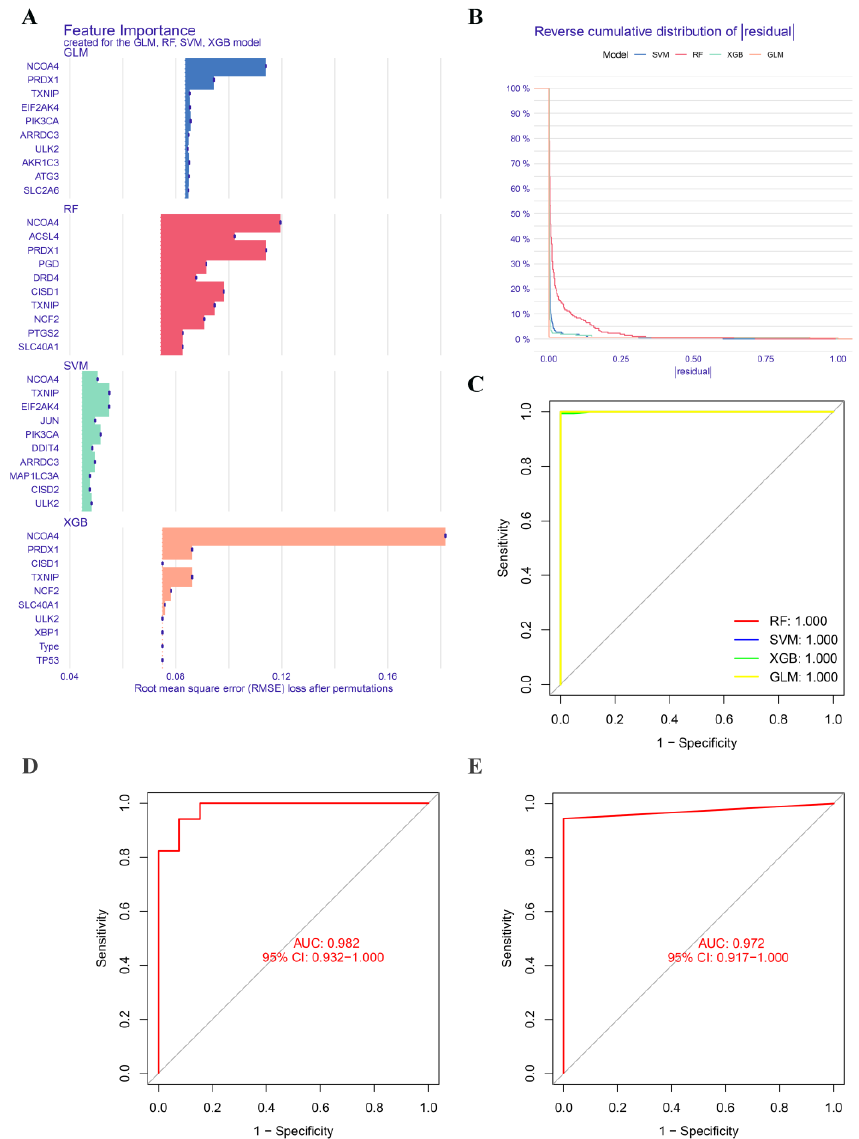
Figure 6. Construction and validation of machine learning models. ( A ) The feature importance cre- ated by four machine learning models. ( B ) Reverse cumulative distribution of residuals in four ma- chine learning models. ( C ) Receiver operator characteristic (ROC) analysis of four machine learning models. ROC analysis of the 5-gene-based diagnostic model in GSE41849 batch GSE113004 ( D ), and GSE103005 ( E ) datasets.